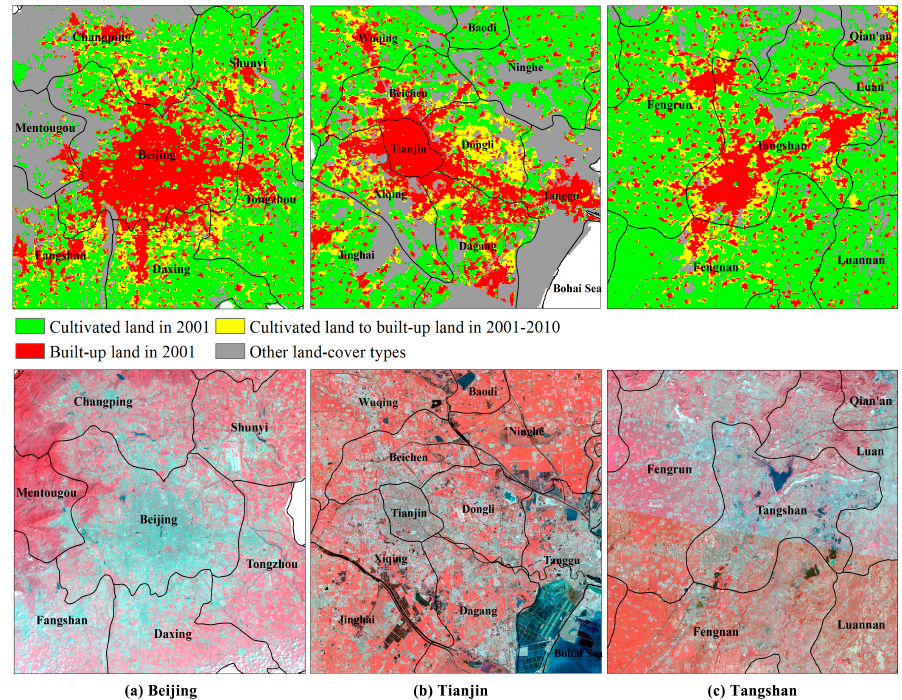
Figure 17. The change detection results in the main urban district in Beijing, Tianjin, and Tangshan from 2001 to 2010. ( a ) The change detection result in Beijing ( top ) and the corresponding Landsat-5 TM image acquired in 8 August 2010 ( bottom ). ( b ) The change detection result in Tianjin (top) and the corresponding Landsat-5 TM image acquired in 4 October 2010 ( bottom ). ( c ) The change detection result in Tangshan (top) and the corresponding Landsat-5 TM image acquired in 4 October 2010 ( bottom